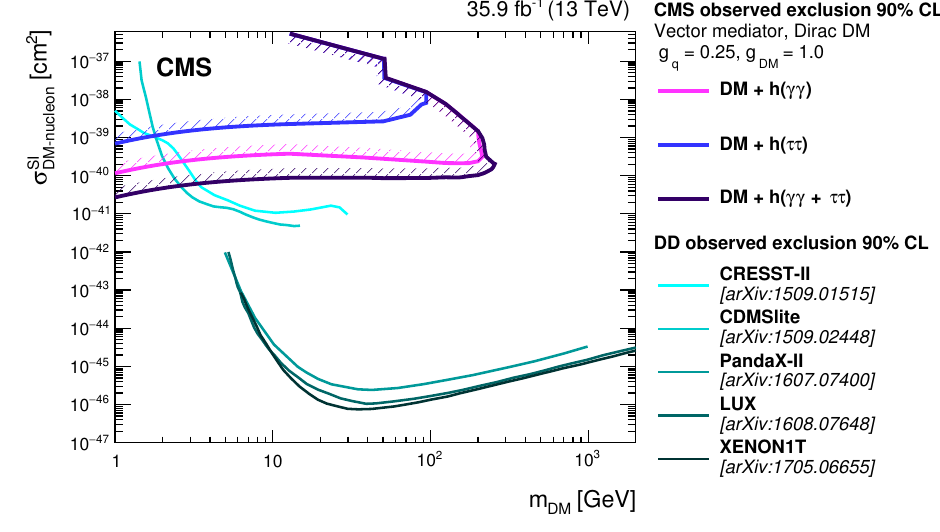
Figure 9 . The 90% CL exclusion limits on the DM-nucleon SI scattering cross section as a func- tion of m DM . Results obtained in this analysis are compared with those from a selection of direct detection (DD) experiments. The latter exclude the regions above the curves. Limits from CDM- SLite [67], LUX [68], XENON-1T [69], PandaX-II [70], and CRESST-II [71] are